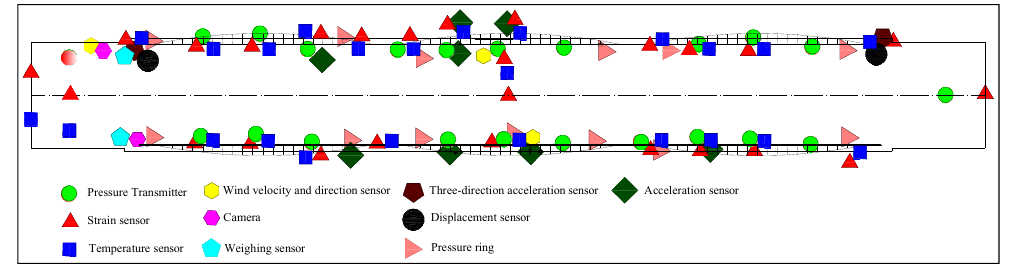
Figure 5. Layout of sensors on Jiubao Bridge.